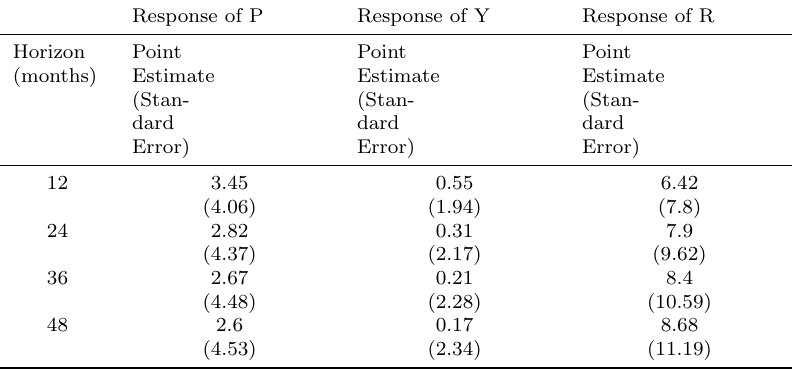
Table 5: VDCs of P, Y and R with ordering D, Y, P, R, M2, T (Estimation period: 2009:08 - 2020:01) Response of P Response of Y Response of R